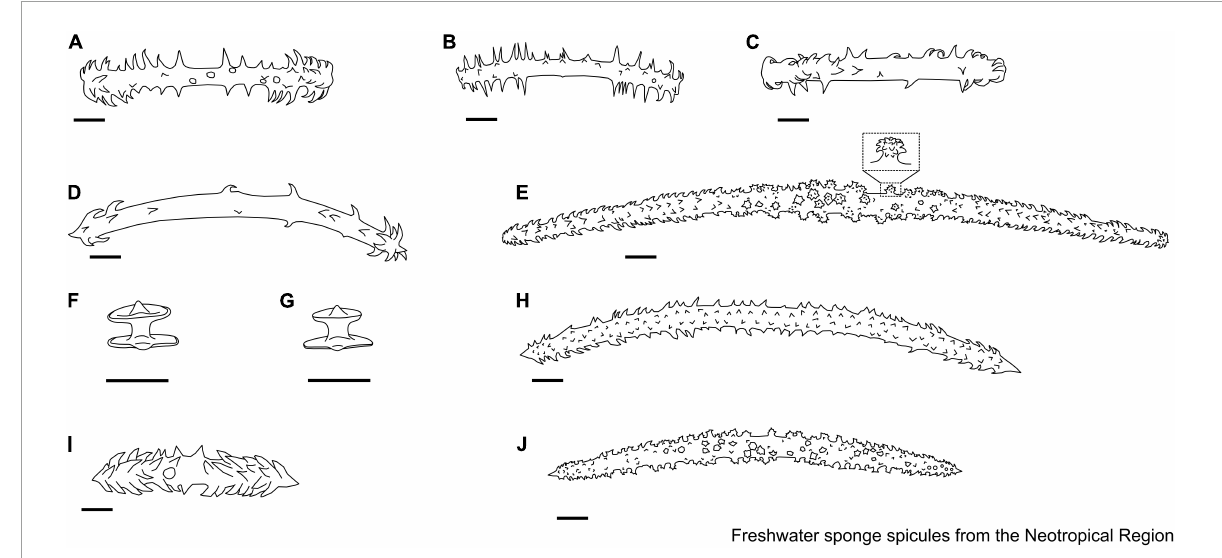
FIGURE8 (A–C) Radiospongilla Penney & Racek, 1968. Gemmuloscleres. (A) Acanthostrongyles, the spines are concentrated at the tips, forming hooks; (B) acanthostrongyles, the spines are straight and sharp; (C) pseudobirotule with spiny shaft and bent long spines at the apices. (D,E) Rosulaspongilla Sokolova, Palatov, Masuda & Itskovich, 2021. Gemmuloscleres. (D) Acanthoxeas with large, curved spines more thickly accumulated at the tips and often form mace-shaped structures; Microscleres. (E) Fusiform acanthoxeas densely spined with complex spines in the middle and simple spines at the tips. (F–H) Saturnospongilla Volkmer-Ribeiro, 1976. Gemmuloscleres. (F,G) Birotules with the smooth shaft and entire margins; (H) Acanthoxeas with conical spines. (I,J) Spongilla (Lamarck, 1816). Gemmuloscleres. (I) Acanthoxeas is straight and curved, entirely covered with recurved spines; Microscleres. (J) Acanthoxeas with simple and composed spines. Scale: 10 µ m.